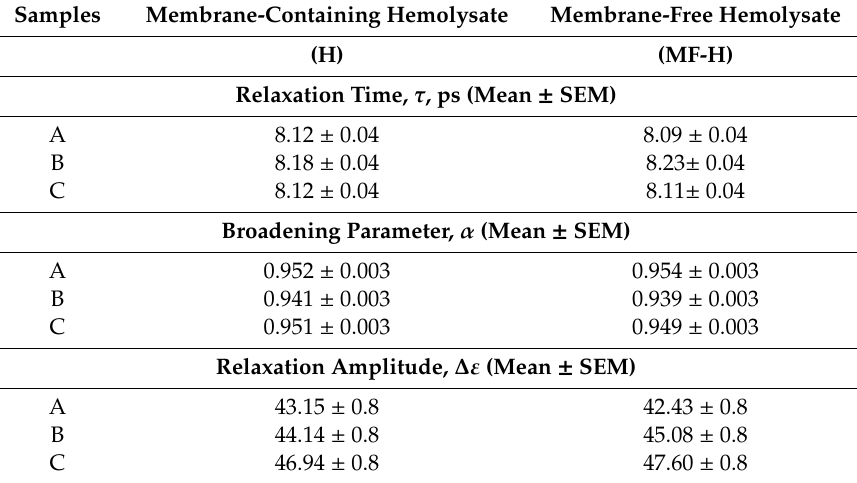
Table 2. Comparison of the relaxation time τ , the broadening parameter α , and the relaxation amplitude ∆ ε of water for membrane-containing (H) and membrane-free (MF-H) hemolysates. Each datum is the mean ± SEM from six repeated